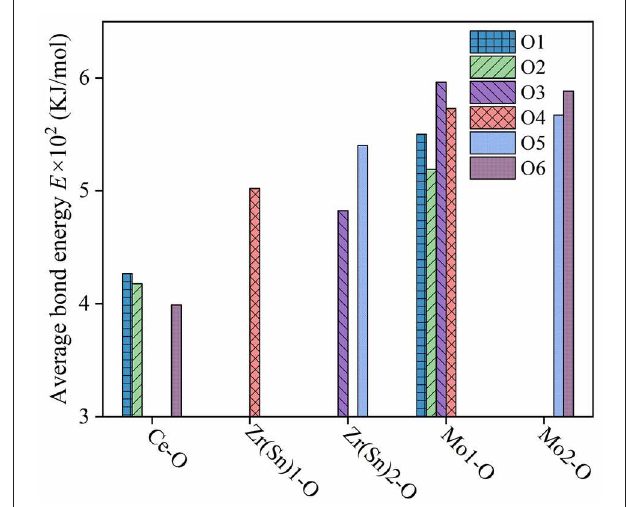
FIGURE 10 | Bond energy of different bond type for Ce